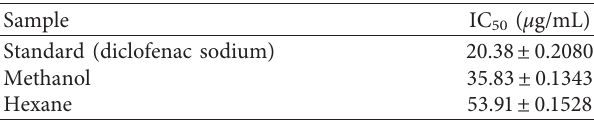
Figure 1: Percentage in vitro anti-inflammatory action of methanol and hexane extracts of V. camporum . Results were expressed as mean ± SEM ( N � 3); ∗∗∗ P < 0 . 001 compared to diclofenac sodium (reference drug) using one-way ANOVA. Table 2: IC 50 of anti-inflammatory activity of extracts of V. camporum